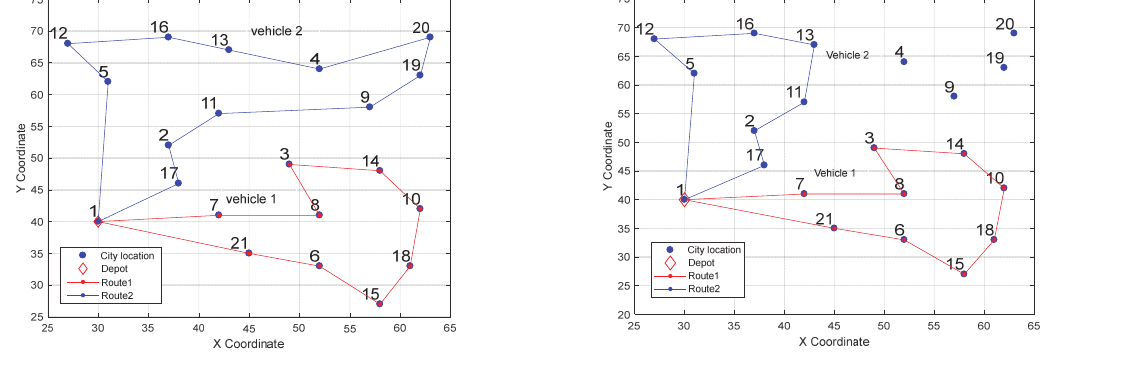
Fig. 4. Optimal LPG distribution route plan of CVRP Fig. 5. Optimal LPG distribution route plan of CTVRP